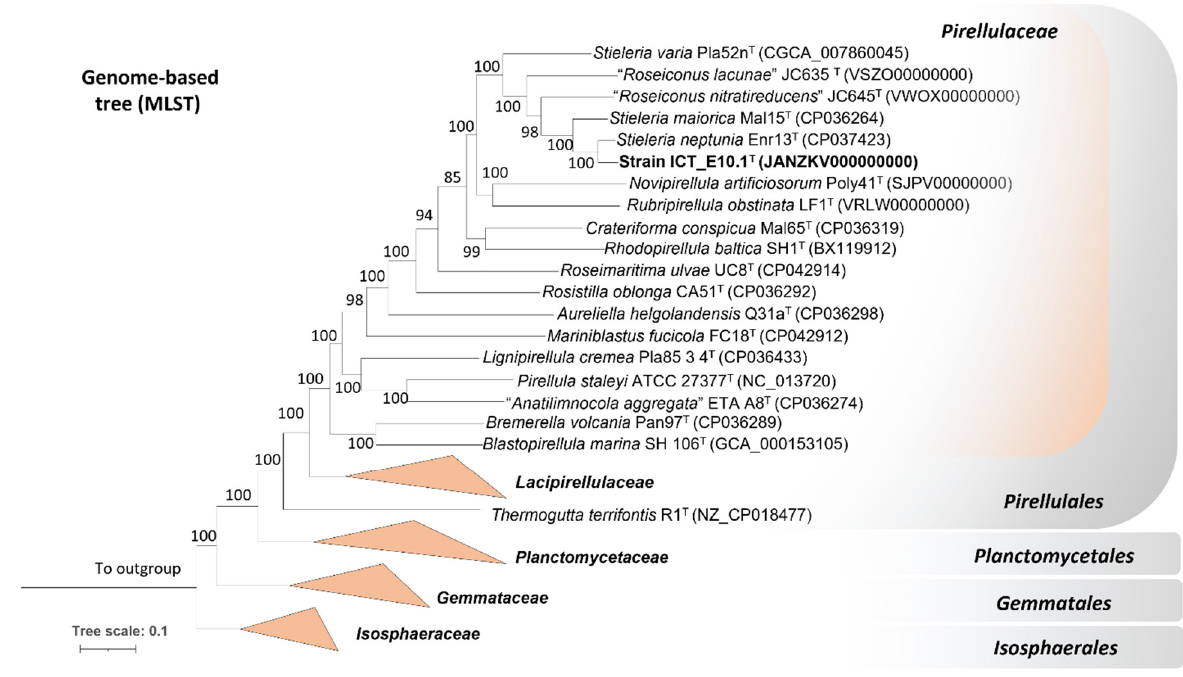
Figure 2. Genome-based tree (MLS) consolidating the affiliation of strain ICT_E10.1 T to the family Pirellulaceae in the genus Stieleria but as a separate species. Other genomes utilized in this tree were retrieved from NCBI and the GenBank tags given in parenthesis. Members belonging to other families in class Planctomycetia collapsed at the family level. The bootstrap used in this tree was 1000 and the respective percentages shown at the nodes (in %). Three Streptomyces spp. (phylum Actinomycetota ) were used as outgroups.